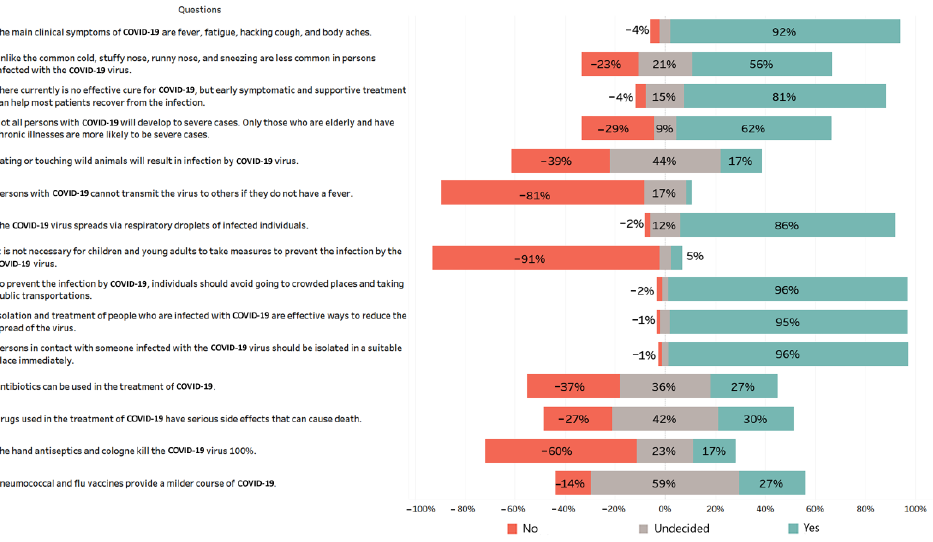
Figure 2. Knowledge levels of the participant on COVID-19 ( n = 664).